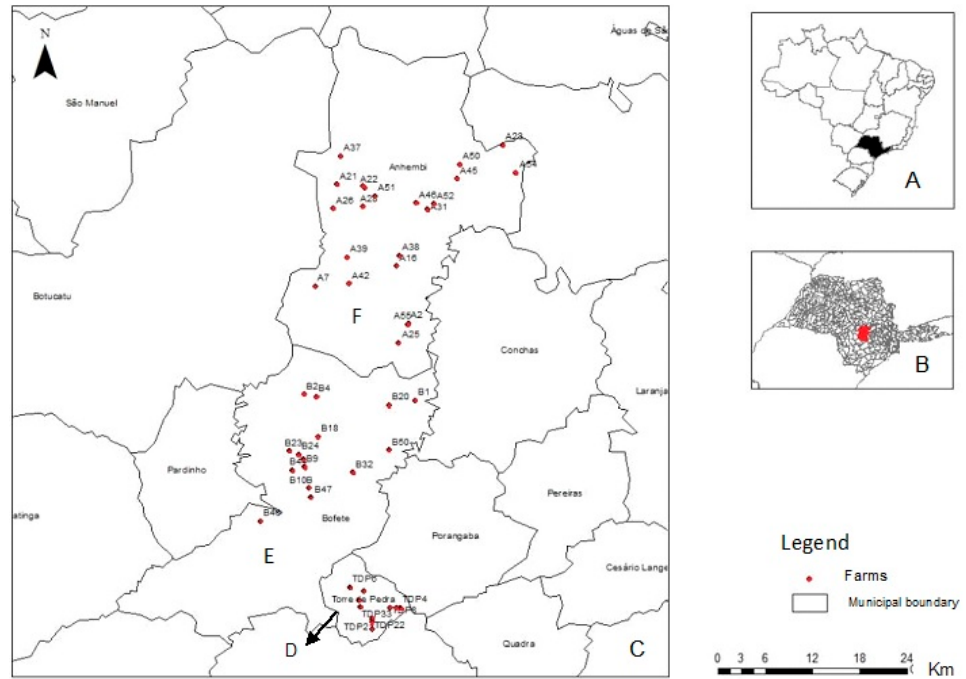
Figure 1. Map of sites sampling, ( A ) with São Paulo State in black. The São Paulo state map; ( B ) with Torre de Pedra, Bofete and Anhembi in red. The Map of São Paulo State; ( C ) showing the sites of sampling; the points in red correspond to farms in Torre de Pedra ( D ); Bofete ( E ) and Anhembi ( F ). Source: Peres et al., 2013 [18].